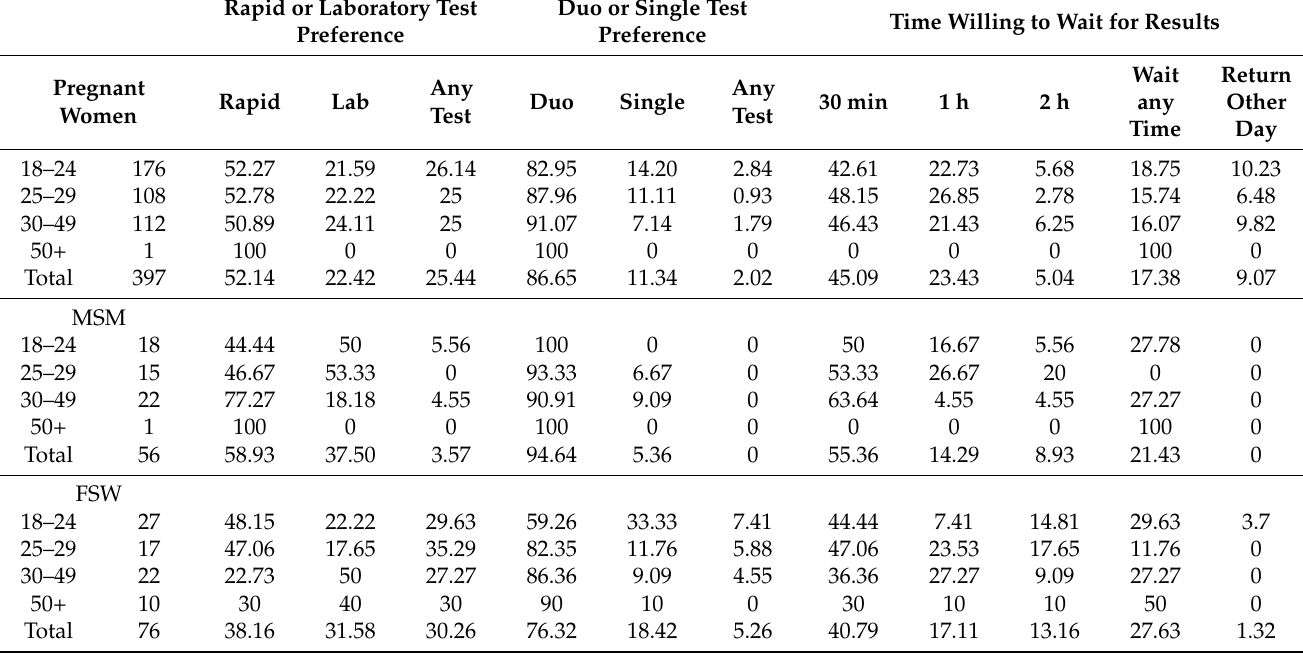
Table 3. Acceptability of the HIV-syphilis rapid diagnostic test among pregnant women, MSM and FSW.